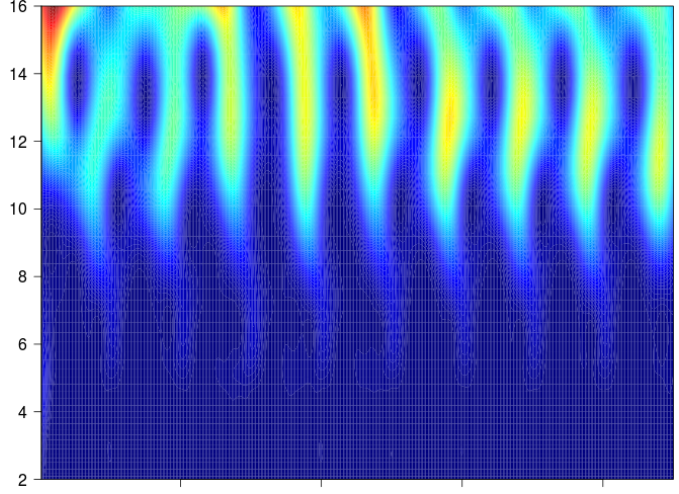
Figure 4. Wavelet spectrum of a week of electrical load